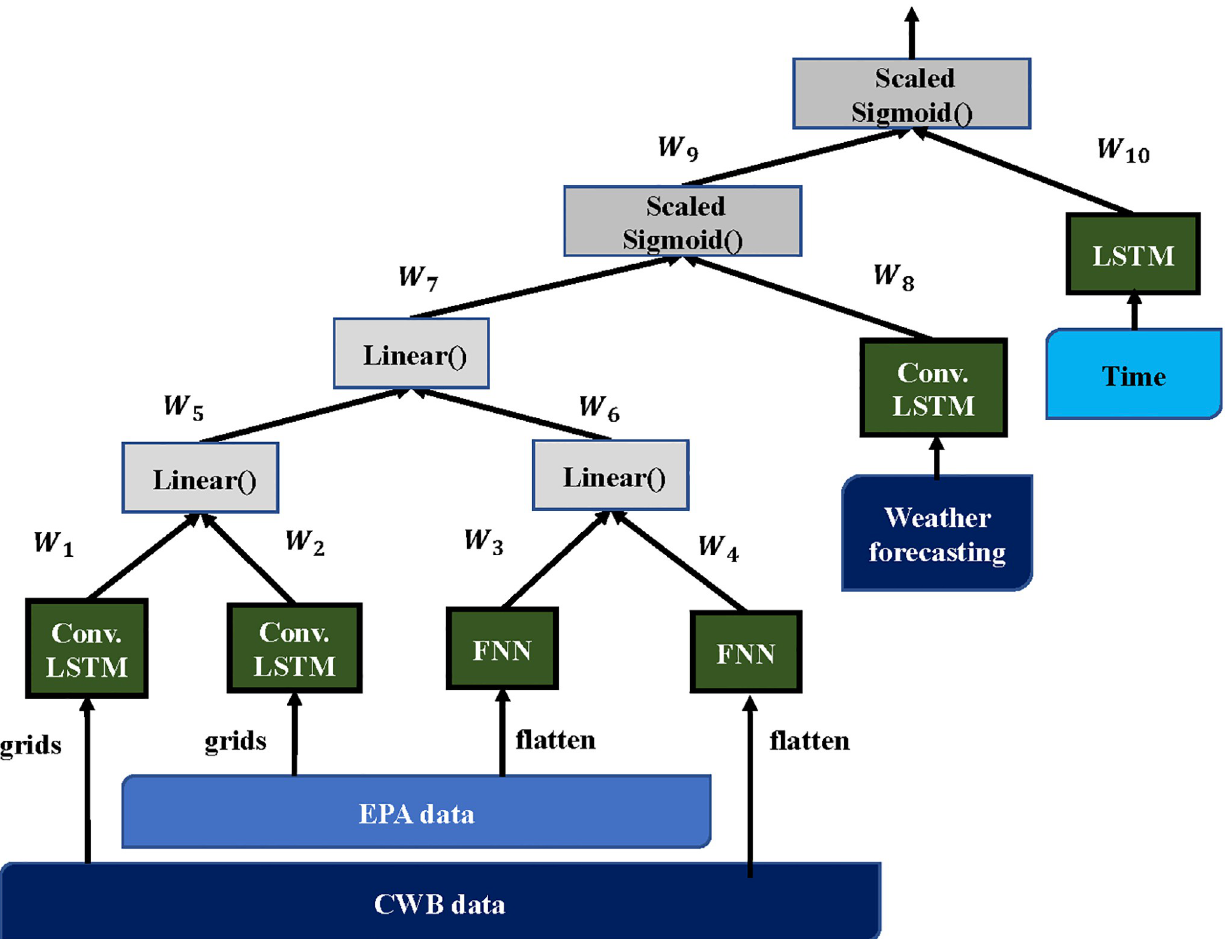
Fig 3. Base model. Structure for Base model for next 24 and 48